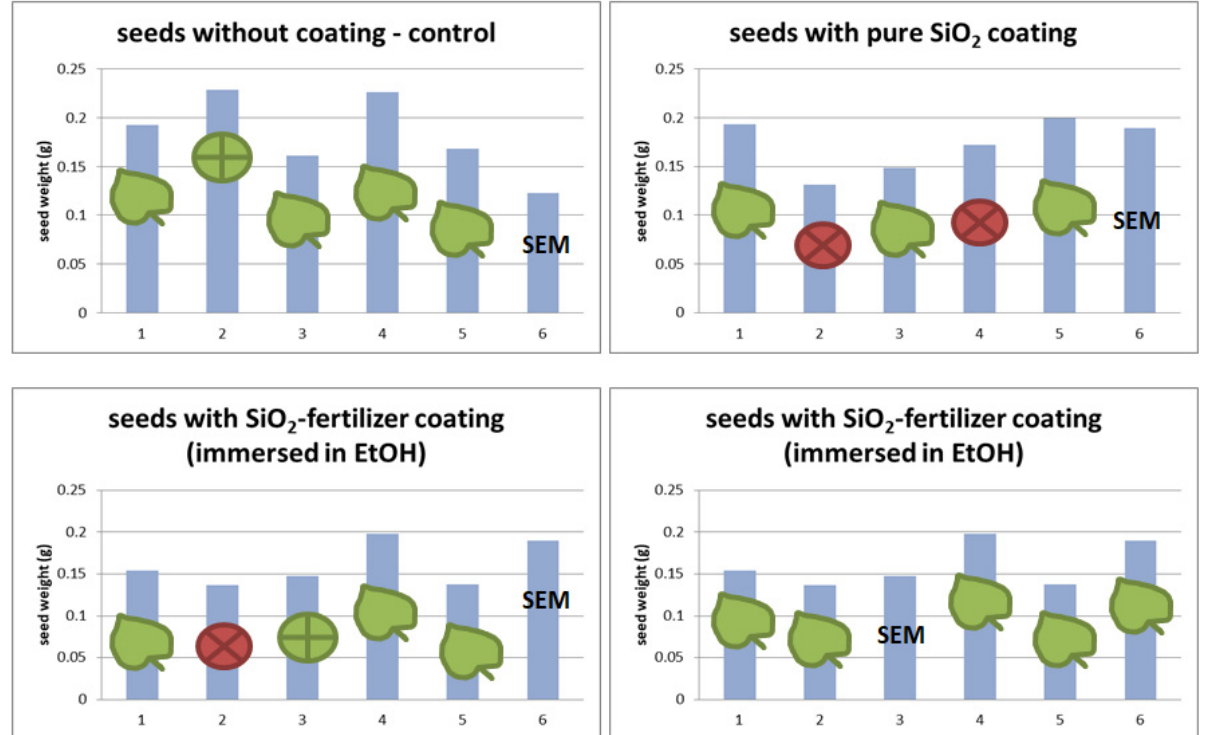
Figure 4. Weights of the seeds chosen for the germination test: “leaf”—seed sprouted and development; “+”—seed sprouted; “×”—seed not sprouted; “SEM”—seed intended for SEM test.